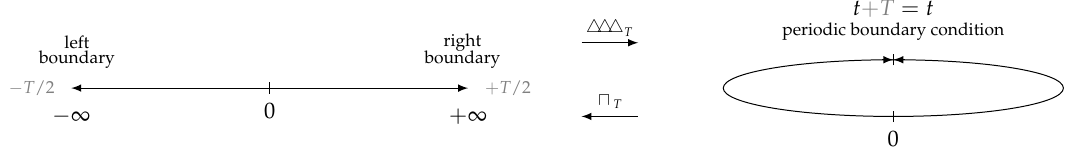
Figure 4. The real axis before ( left ) and after ( right ) periodization, T replaces